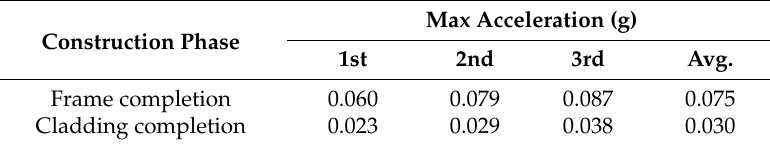
Table 9. Maximum acceleration (South-North church).